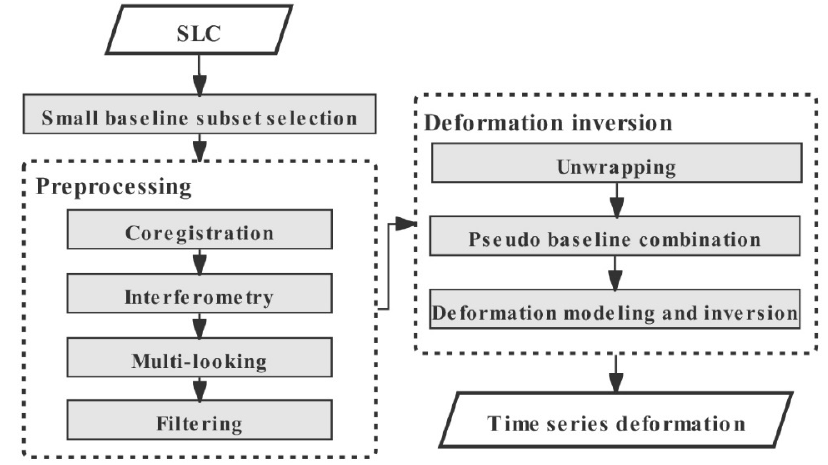
Figure 1. Work flow of the pseudo-combination SBAS method.